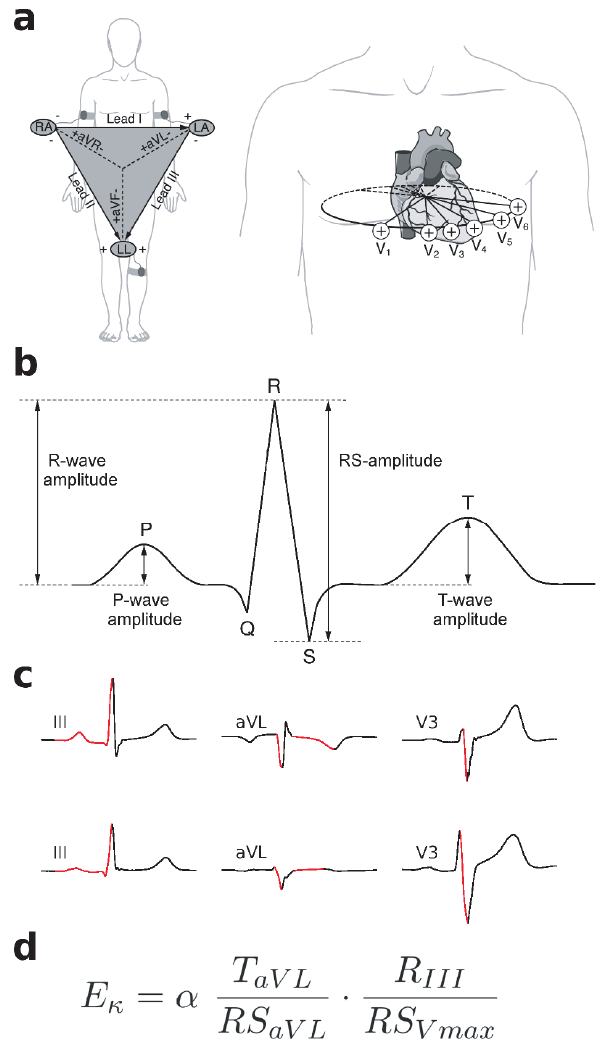
Figure 1. Illustration of ECG waves and E k values. ( a ) Illustration of standard ECG leads: The six extremity leads (I, II, III, aVL, aVR, aVF) record voltage differences by means of electrodes placed on the limbs (left panel). The triangle shows the spatial relationships of the extremity leads, which record electrical voltages onto the frontal plane of the body. The six chest leads (V1–V6) record voltage differences by means of electrodes placed on the chest wall (right panel). The oval indicates spatial relationships of the six chest leads, which record electrical voltages transmitted onto the horizontal plane. ( b ) Illustration of ECG amplitude parameters used in the present study (P-, R-, RS-, and T- waves, each wave is measured from each of the twelve ECG leads in each individual). Due to the absence of a Q-wave in some individuals at some leads, the R-wave is measured with regard to the iso-electric line. ( c ) Illustration of ECG amplitude parameters used to calculate E k values (indicated in red): R-wave of III (measured from the baseline preceding the P-wave), RS-complex of aVL, T-wave of aVL, and RS-complex of the chest lead with the maximal RS amplitude (usually V3 or V2). The upper panel shows averaged ECG cycles measured from a male subject with a high E k value ( * 90th percentile of our study population), the lower panel shows averaged ECG cycles from a male subject with a low E k value ( * 10th percentile of our study population). Both subjects had similar body height (184 vs. 185 cm), body weigt (70 vs. 72 kg), and normal QRS axis orientation (96.23 0 vs. 75.24 0 ). Note the smaller T-wave in aVL in relation to the RS-wave in aVL, and the smaller R-wave in III in relation to the RS-wave in V3, in the subject with low E k value (lower panel), compared to the subject with high E k value (upper panel). ( d ) Equation for computation of E k values. Computation of the